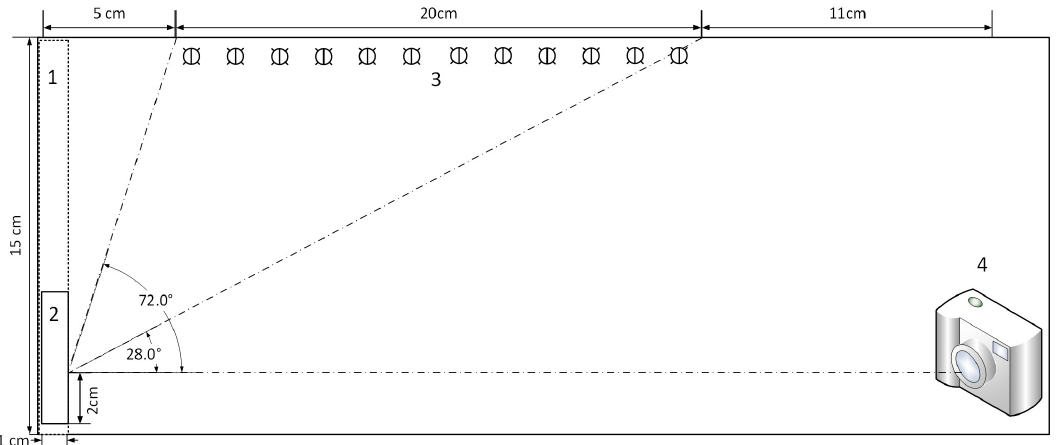
Figure 1. Illustration of colorimetry